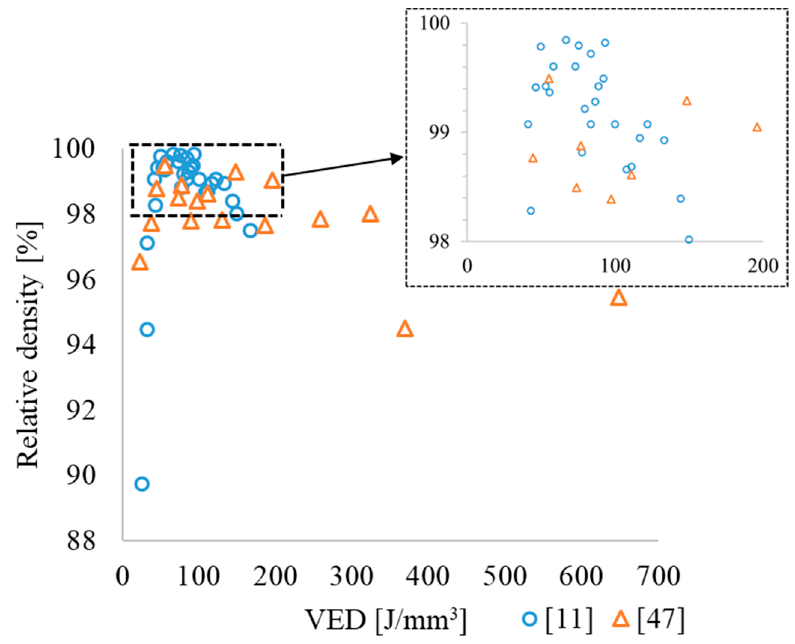
Figure 6. Influence of VED on the relative density of Ti 2 AlNb based alloy L-PBF coupons based on the data from [11,47].